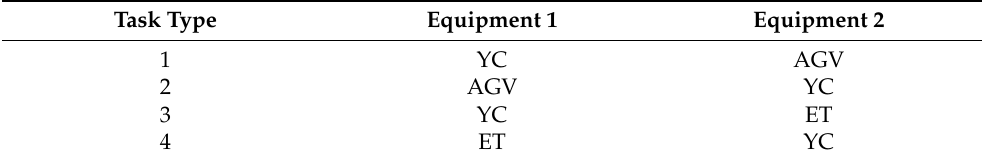
Table 3. Task type.